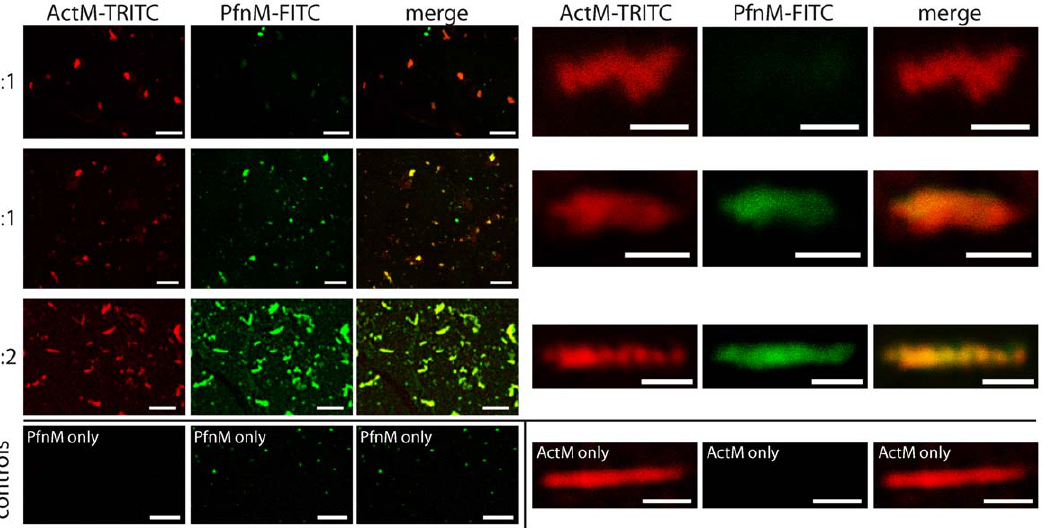
Figure 8. Fluorescence microscopy of PfnM binding to ActM polymers. FITC stained PfnM (green) co-localizes with phalloidin-TRITC stained ActM polymers (red). Single ActM bundles are covered with PfnM along their length. Fluorescence signals increase with increasing PfnM concentration, molar ratios of ActM:PfnM are indicated. Images on the left hand side show an overview (scale bars: 5 m m), magnifications of corresponding single aggregates are on the right (scale bars: 2 m